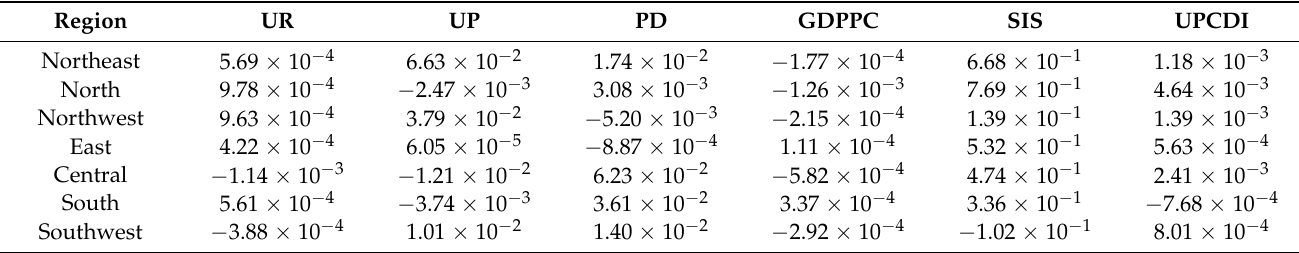
Table A2. The estimated coefficients of GTWR in seven regions.